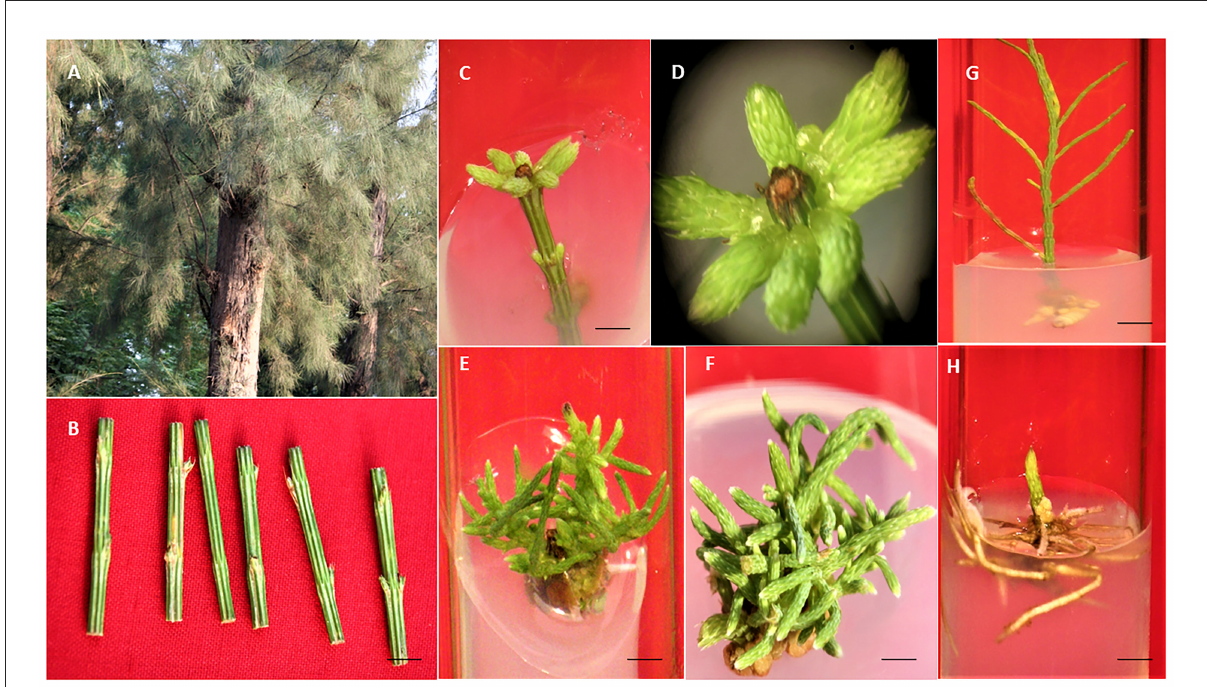
FIGURE1 In vitro propagation protocol in C. equisetifolia . (A) Mother plant. (B) NS (Bar = 0.72cm). (C) Shoot induction on MS + BA (5.0 µ M) (3 weeks old) (Bar = 0.58cm). (D) Close view of culture A (Bar = 0.58cm). (E) Multiple shoots on MS + BA (5.0 µ M) (8 weeks old) (Bar = 0.61cm). (F) Multiple shoots on MS + BA (5.0 µ M) + NAA (0.5 µ M) (8 weeks old) (Bar = 0.62cm). (G) Root initiation on half strength ½ MS + NAA (2.5 µ M) (2 weeks old) (Bar = 0.43cm). (H) multiple roots on ½ MS + NAA (2.5 µ M) (6 weeks old) (Bar = 0.21 cm).